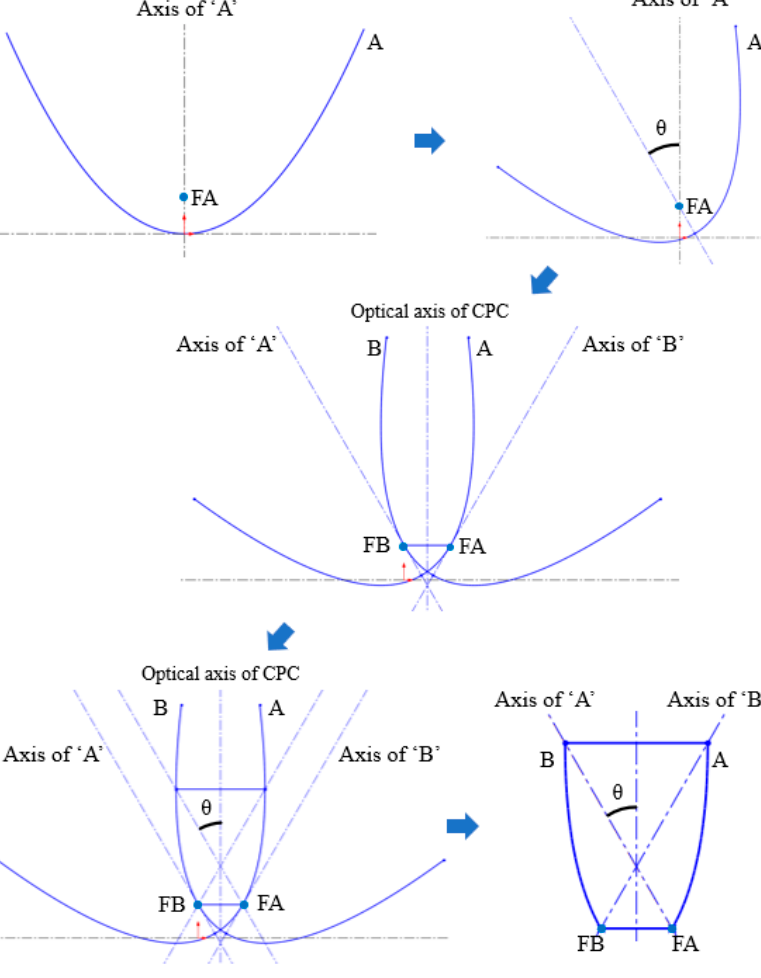
Figure 1. The steps for constructing a compound parabolic curve (CPC).